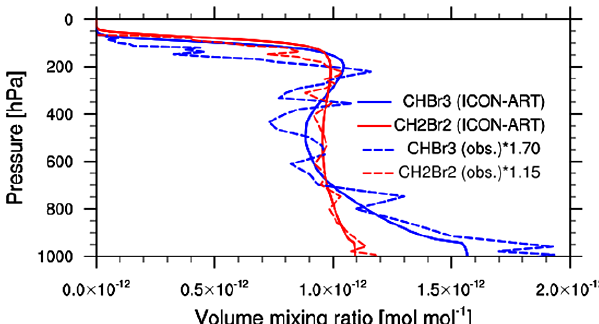
Figure 6. Mean vertical profiles between 20 ◦ S and 20 ◦ N of CHBr 3 (red) and CH 2 Br 2 (blue) volume mixing ratio simulated by ICON– ART for 1 October 2012 (solid lines) and observed during different campaigns (dashed lines). Please note that, the observed mean trop- ical profiles have been multiplied by 1.70 for CHBr 3 and 1.15 for CH 2 Br 2 . See text for more